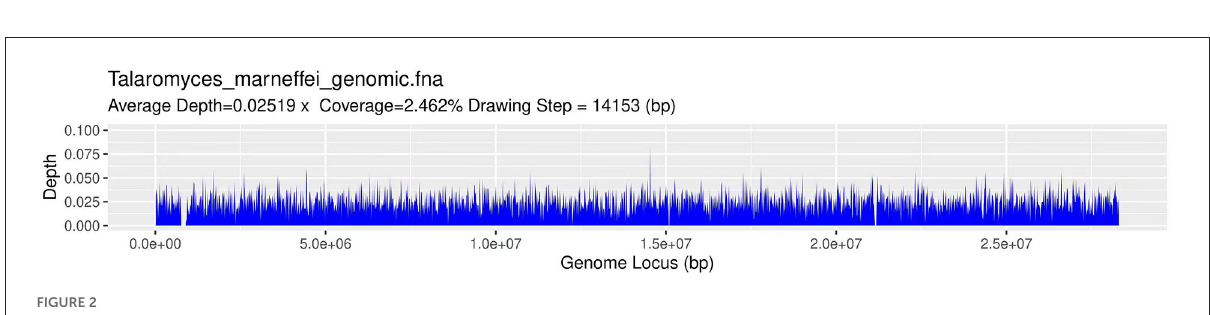
FIGURE2 The coverage depth for Talaromyces marneffei